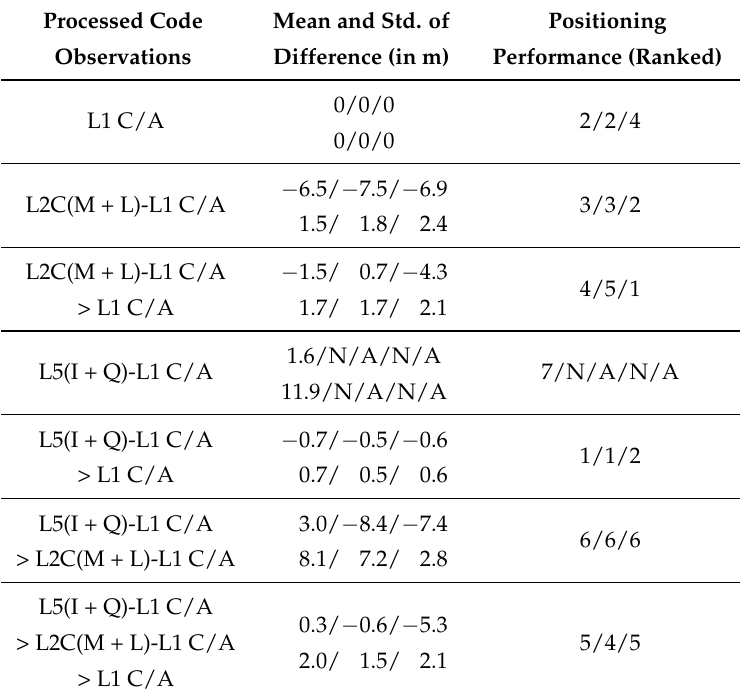
Table 2. Differences in Estimated Receiver Clock Bias (Compared to Single-Frequency L1 C/A Processing) and Positioning Performance for Three Sets of Kinematic Measurement Data. N/A Indicates it was not Possible to Compute a Solution due to a Lack of Available GPS Block IIF